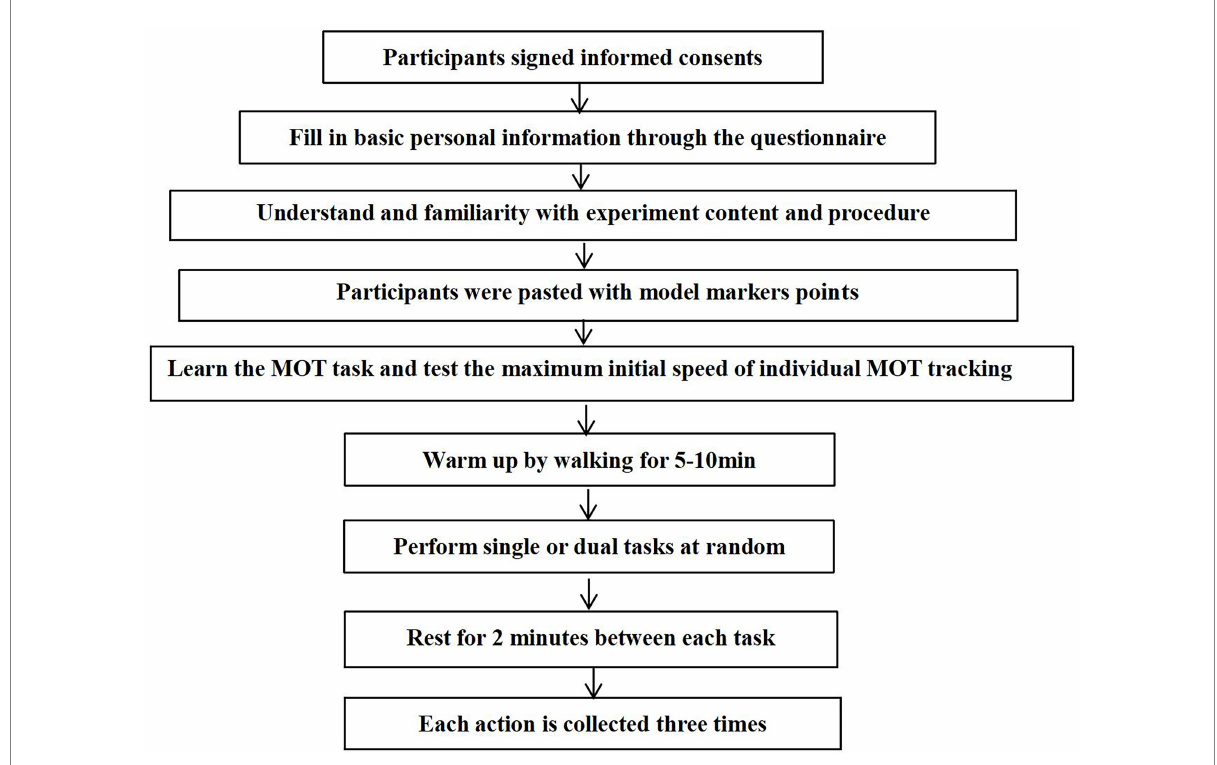
FIGURE 2 Schematic representation of the study